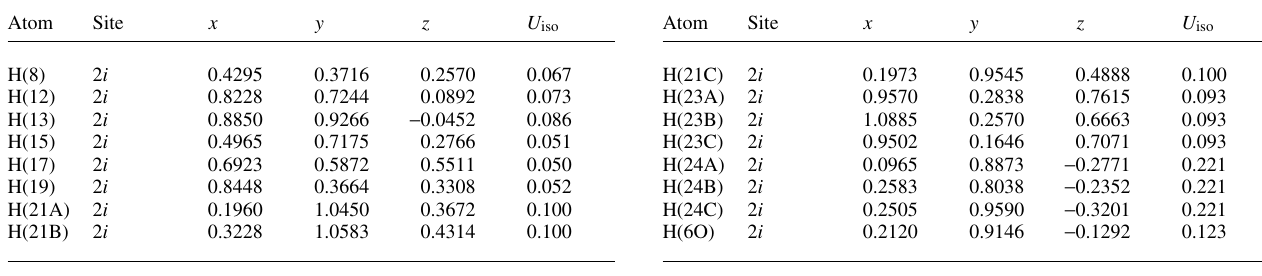
Table 3. Atomic coordinates and displacement parameters (in Å 2 )